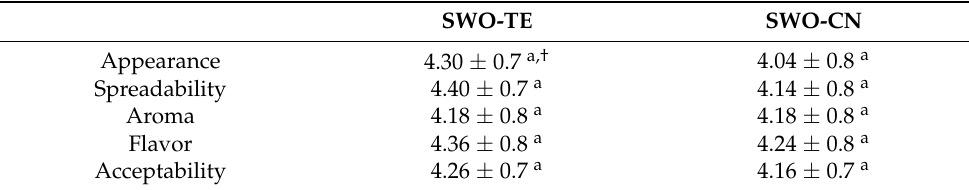
Table 5. The consumer test results of the prepared thyme and cumin-flavored virgin olive oil-sunflower wax